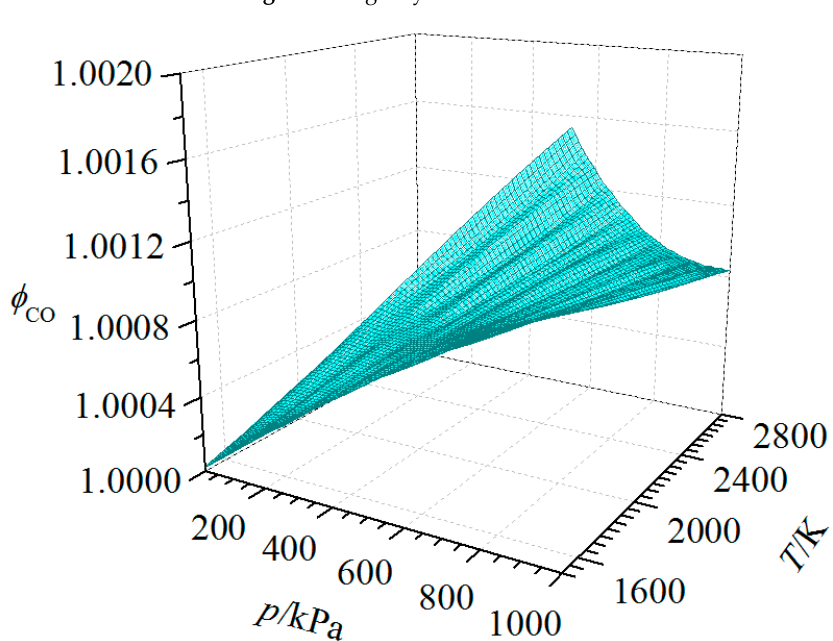
Figure 4. Fugacity coefficient of CO.